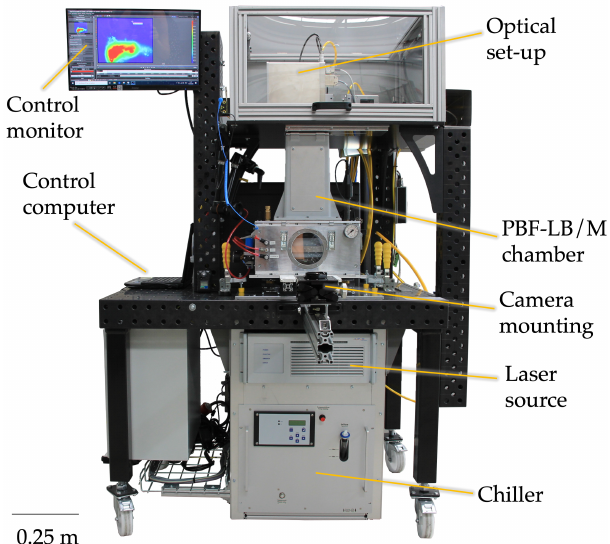
Figure 2. Experimental setup for the process monitoring during PBF-LB/M.